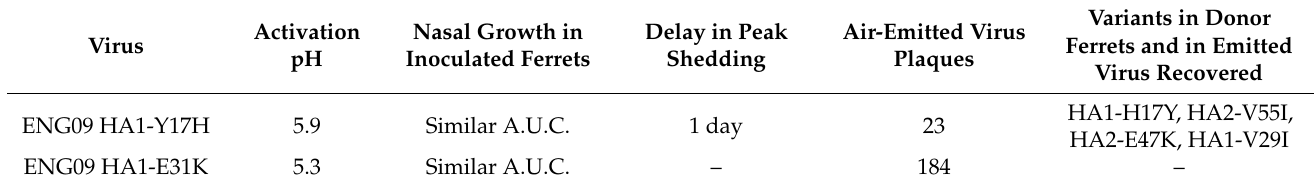
Table 5. A/England/195/2009 (H1N1) HA stability variants in ferrets [169].